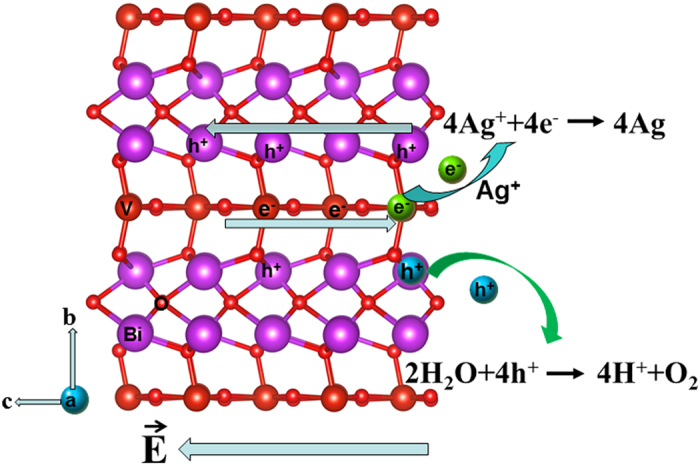
Schematic illustration of the photocatalytic process of Bi4V2O11.